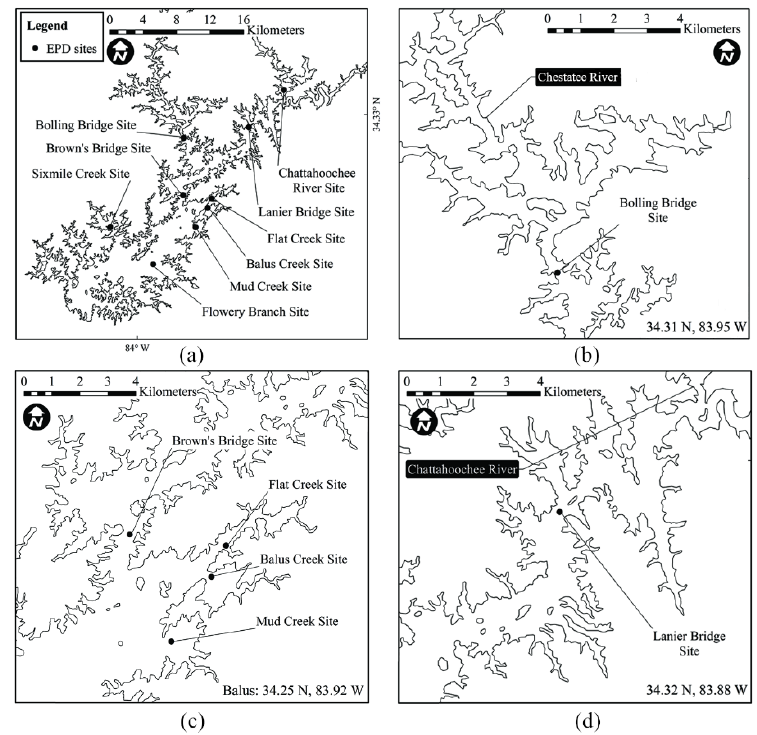
Figure 5. The sampling sites at Lake Lanier are at the two main tributaries, the Chestatee River and the Chattahoochee River, as well as the several embayments formed by smaller inflows. (a) All sites at Lake Lanier; (b) The sites near the Chestatee tributary; (c) The four sites on eastern Lake Lanier; (d) The sites near the Chattahoochee tributary.